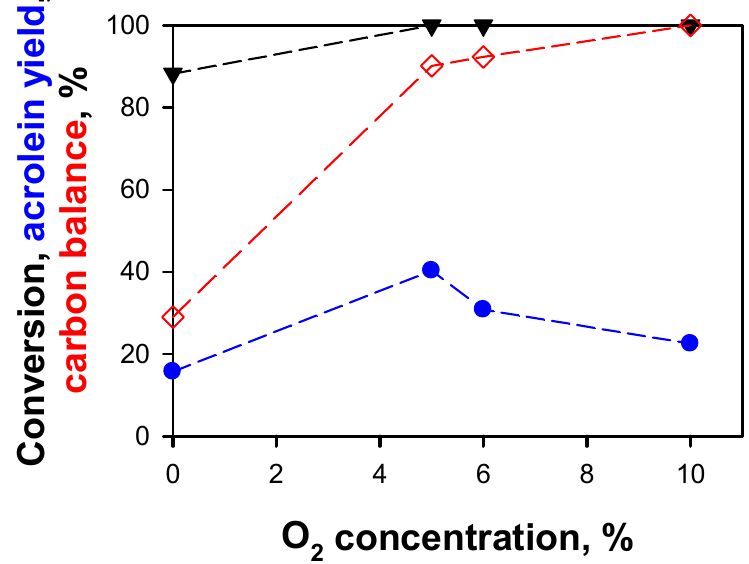
◇ Figure 10. Conversion ( (cid:72) ), yield to acrolein ( Figure 10. Conversion ( ▼ ), yield to acrolein ( ⬤ ), and carbon balance ( ◇ ) as a function of O 2 ), and carbon balance ( (cid:94) ) as a function of O 2 concentration Figure 10. Conversion ( ▼ ), yield to acrolein ( ⬤ ), and carbon balance ( ) as a function of O 2 concentration in the feed on VOP/Al. T = 325 °C; τ = 0.057 g∙s∙cm −3 ; Glycerol = 2 vol. %; H 2 O = 41 vol. in the feed on VOP / Al. T = 325 ◦ C; τ = 0.057 g · s · cm − 3 ; Glycerol = 2 vol. %; H 2 O = 41 vol. %; N 2 = concentration in the feed on VOP/Al. T = 325 °C; τ = 0.057 g·s·cm − 3 ; Glycerol = 2 vol. %; H 2 O = 41 vol. %; N 2 = balance. %; N 2 = balance.